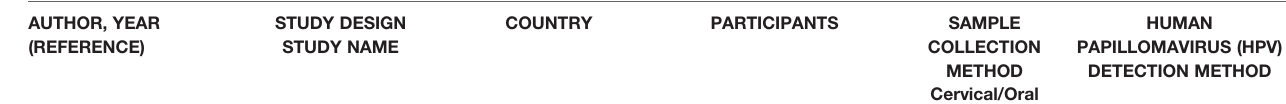
TABLE 2A | Description of methodology used in synchronous oral-cervical HPV evaluation papers